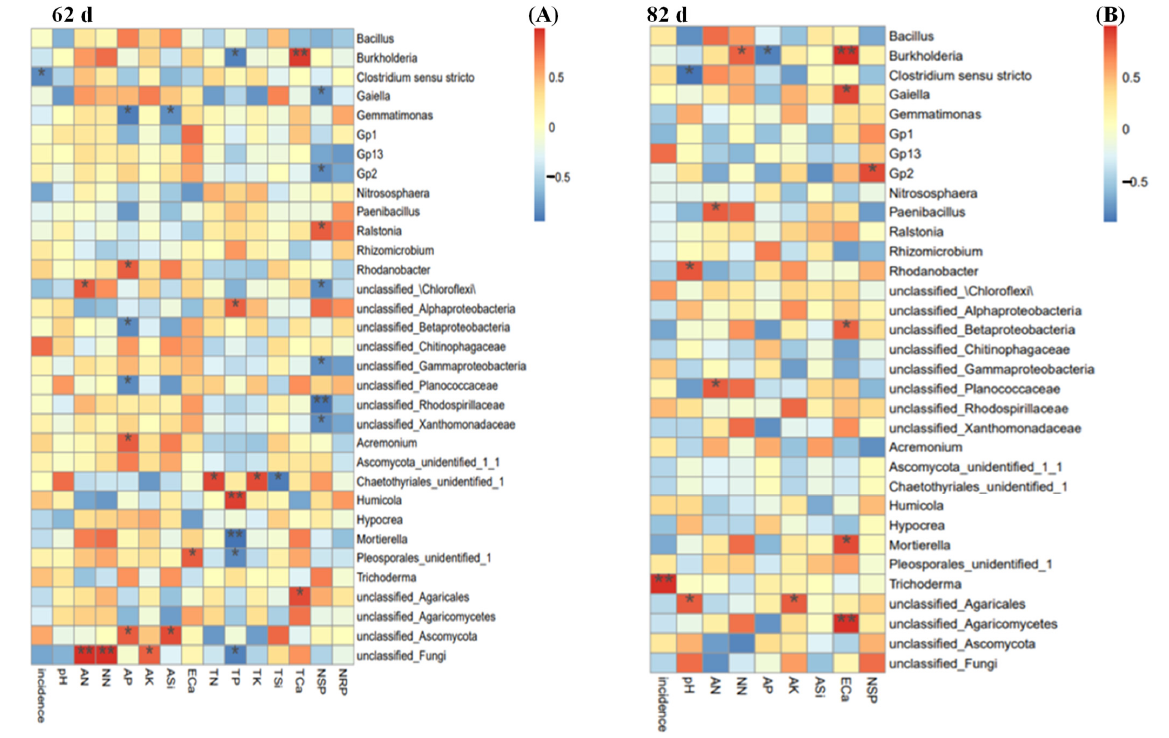
Figure 7. The Spearman correlation analysis of the physicochemical indices (AN, NN, AP, AK, ASi, ECa, TN, TP, TK, TSi, TCa, NSP, NRP) and disease incidence of different treatments at 62 d ( A ) and 82 d ( B ) of transplanting and the soil microbial genera level. p * < 0.05, p ** < 0.01.